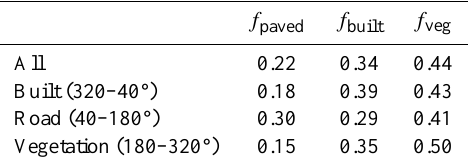
Table 1. Surface cover fractions of paved surface ( f paved ) , buildings ( f built ) and vegetation ( f veg ) inside an 800m radius circle around the measurement tower. Fractions are also given for the different surface cover areas: built, road and vegetation.